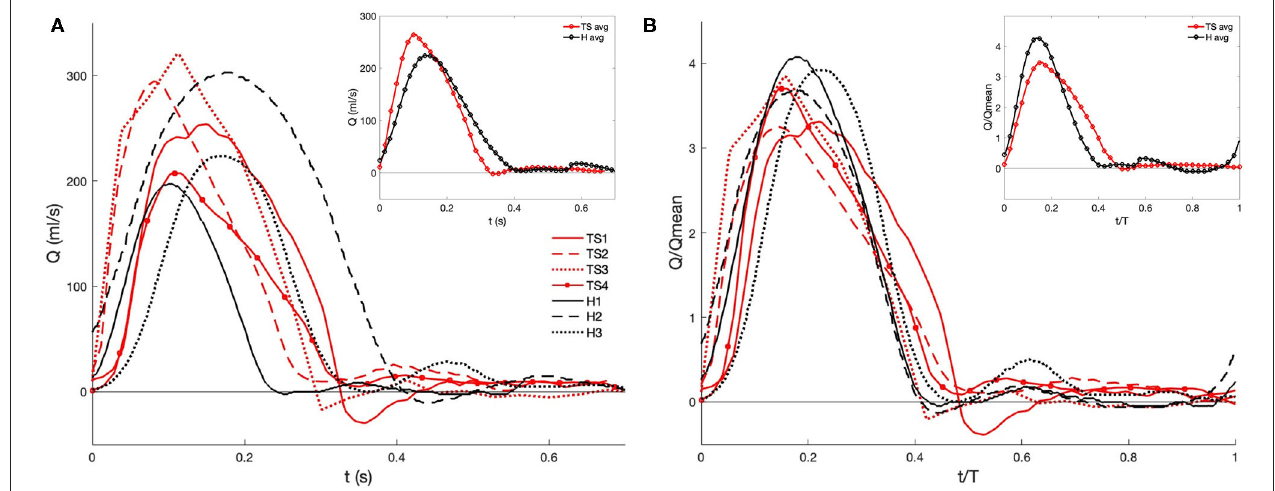
FIGURE 3 | PC-MRI derived (A) volumetric flow rate and (B) normalized waveforms at the aortic root during one cardiac cycle for healthy (H) and Turner syndrome (TS) girls. Insets: average data calculated from H1-H3 (black line) and TS1-TS4 (red line). Flow rate and time normalized by the mean flow rate and cardiac cycle period (see Table 2 for